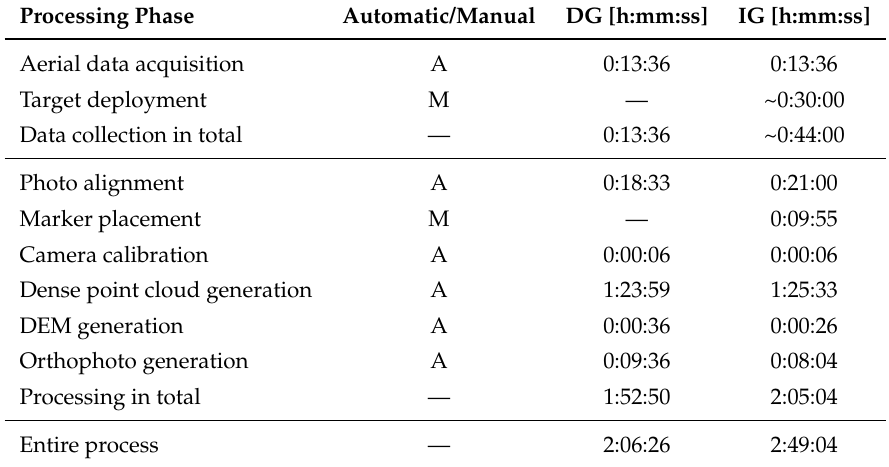
Table 3. The data collection and processing times of the applied techniques; the photogrammetric processing was executed on a personal computer with an Intel Core i7-6700 CPU, 32 GB RAM, and an NVIDIA GeForce GTX 1051 Ti